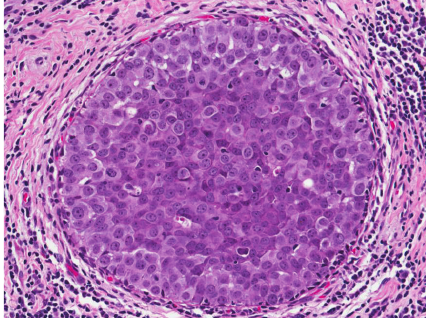
Figure 2: High-grade DCIS. The neoplastic cells demonstrate markedly enlarged nuclei, with significant pleomorphism, coarse chromatin, and lack of polarity.